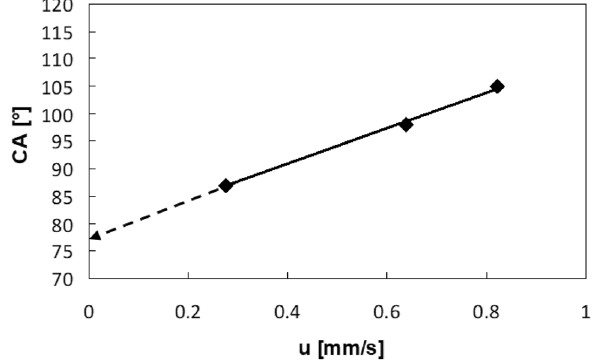
Fig. 7 Contact angle as a function of velocity of the three-phase contact across a solid surface. Sea water – calcite in crude oil at 5.5 MPa and 50 °C. Extrapolation towards u = 0 mm/s is indicated by the dashed